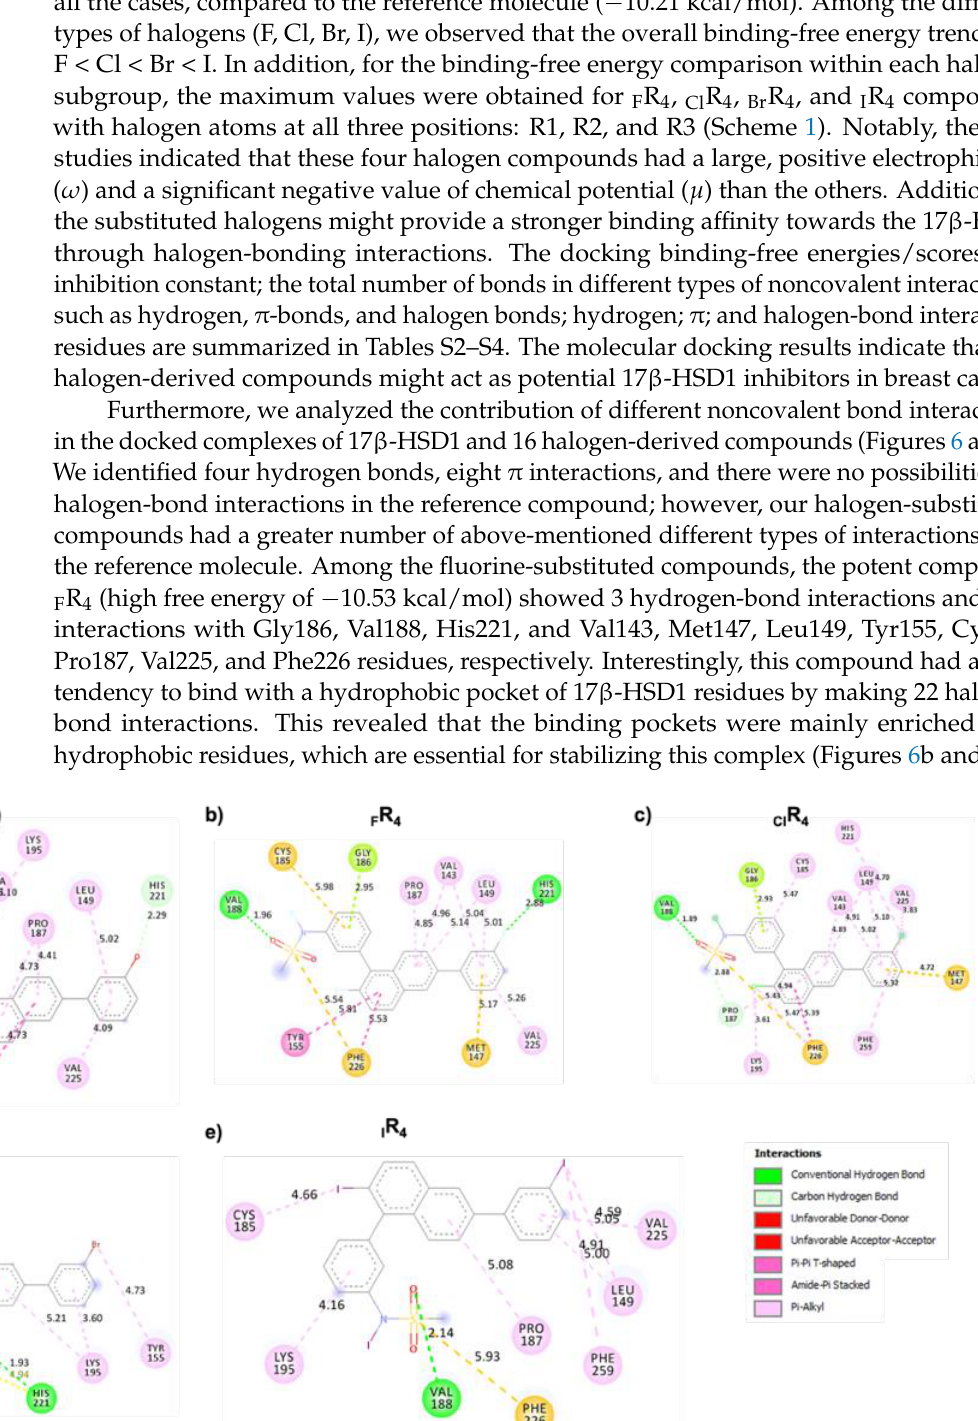
Figure 7. The halogen- bond interactions between 17β -HSD1 and more potent molecules, such as F R 4 , Cl R 4 , Br R 4 , and I R 4 compounds (( a – d ), respectively). Note: here, the compounds are represented by a red color.